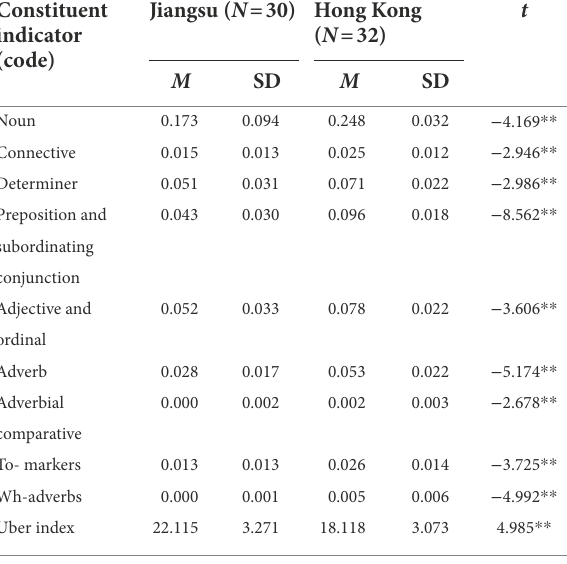
TABLE 1 Lexical differences in written English between learners of the two